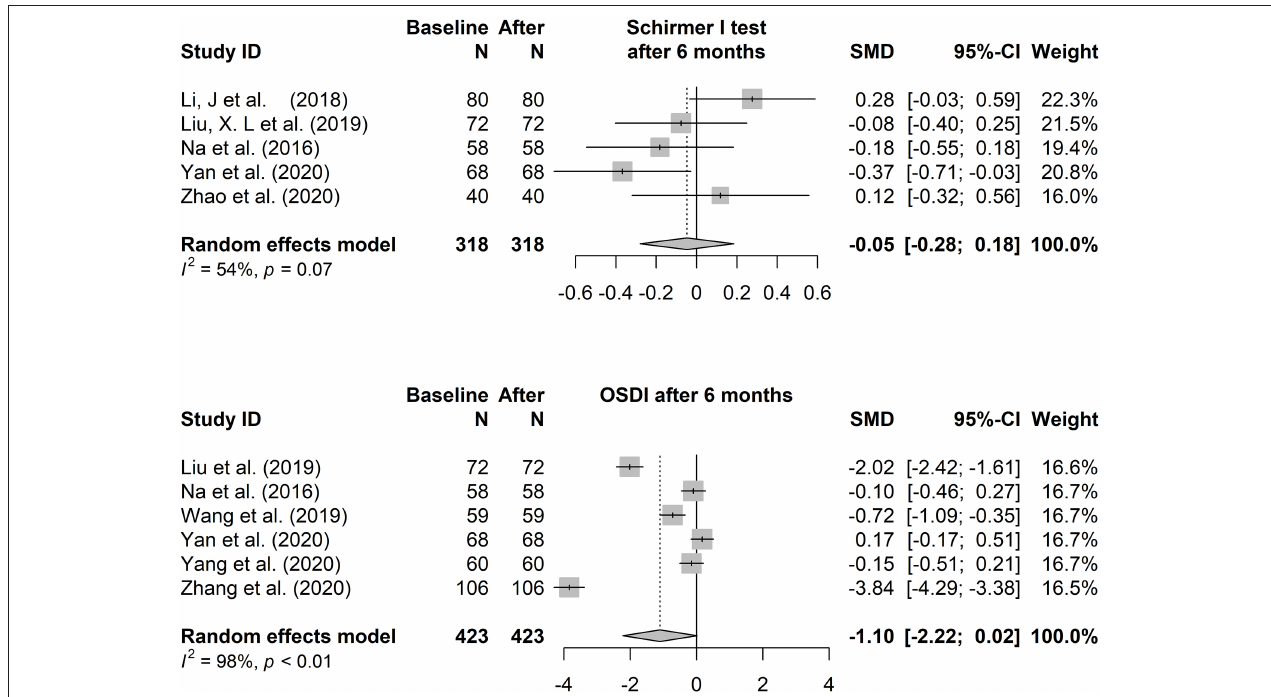
FIGURE 4 | The forest plots of the Schirmer I test and Ocular Surface Disease Index changing after 6 months of orthokeratology